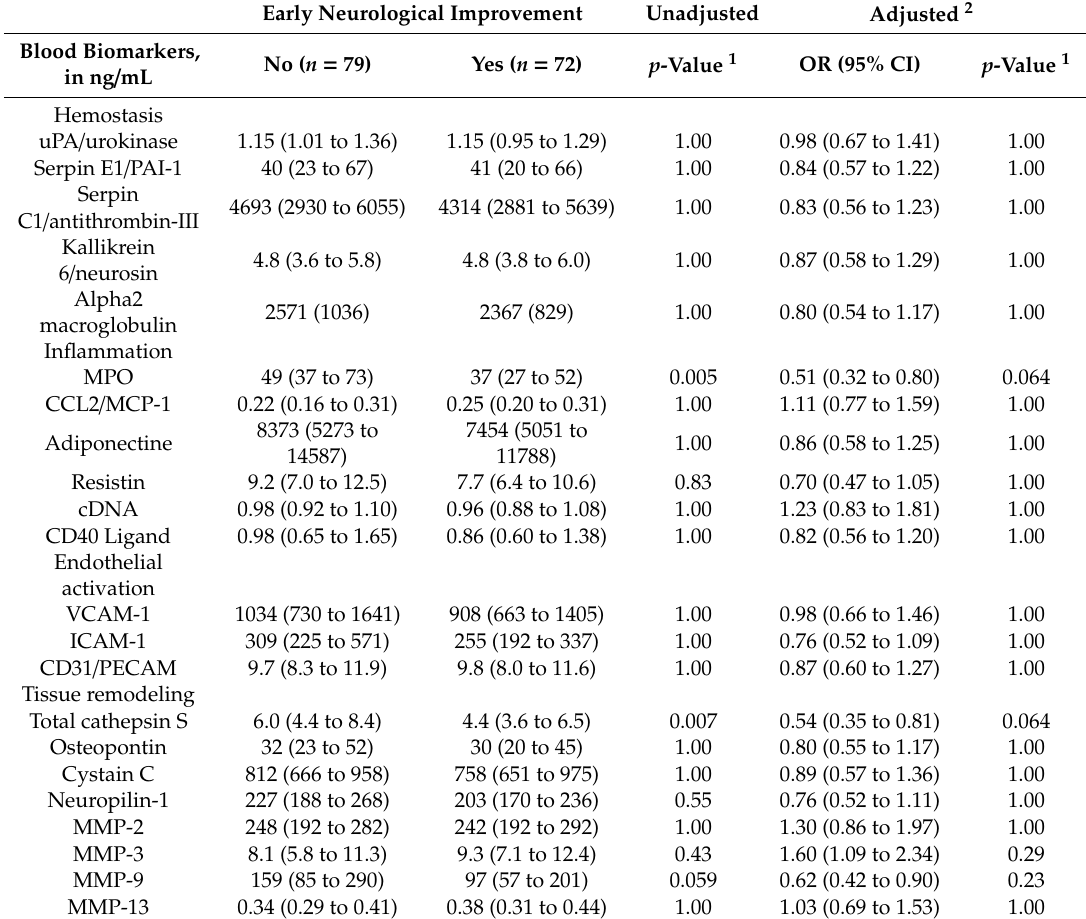
Table 4. Associations of biological markers with early neurological